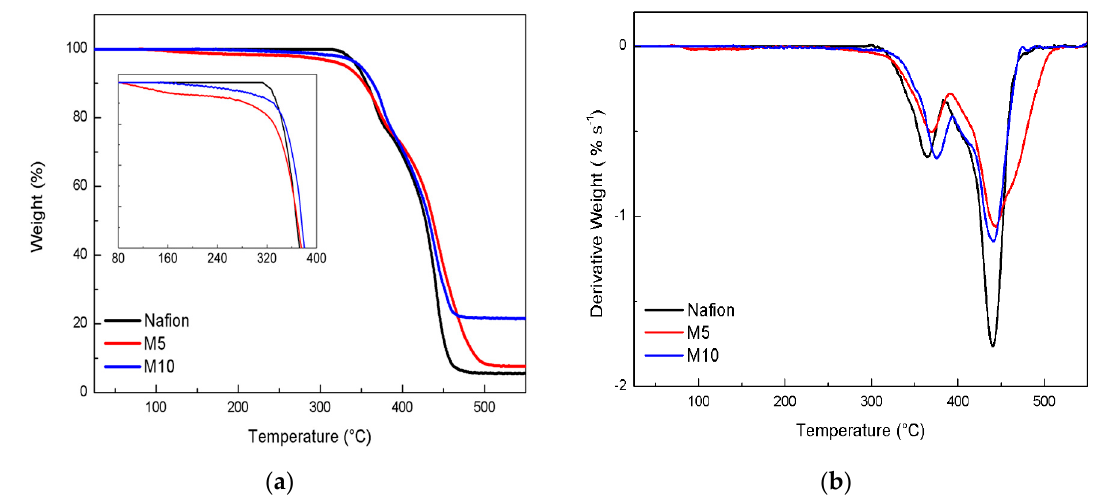
Figure 2. ( a )TG and DTG curves ( b ) recorded for the dry membranes . Figure 2. ( a ) TG and DTG curves ( b ) recorded for the dry